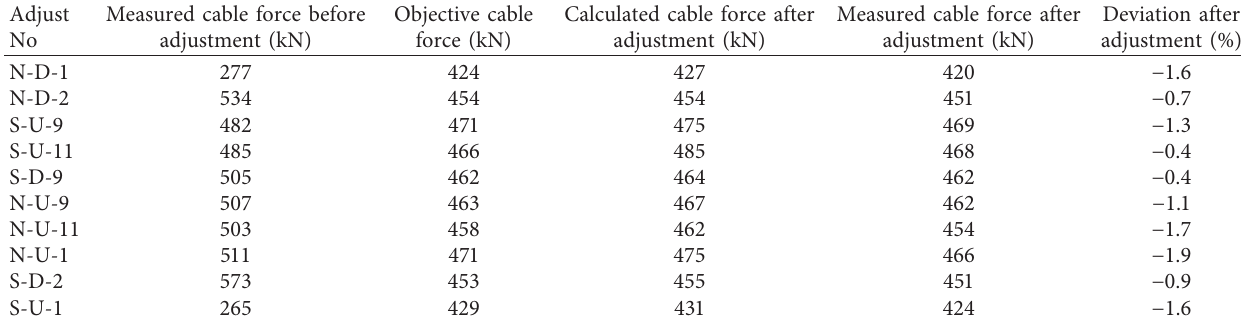
Table 3: Adjusted cables and cable forces before and after adjustment.